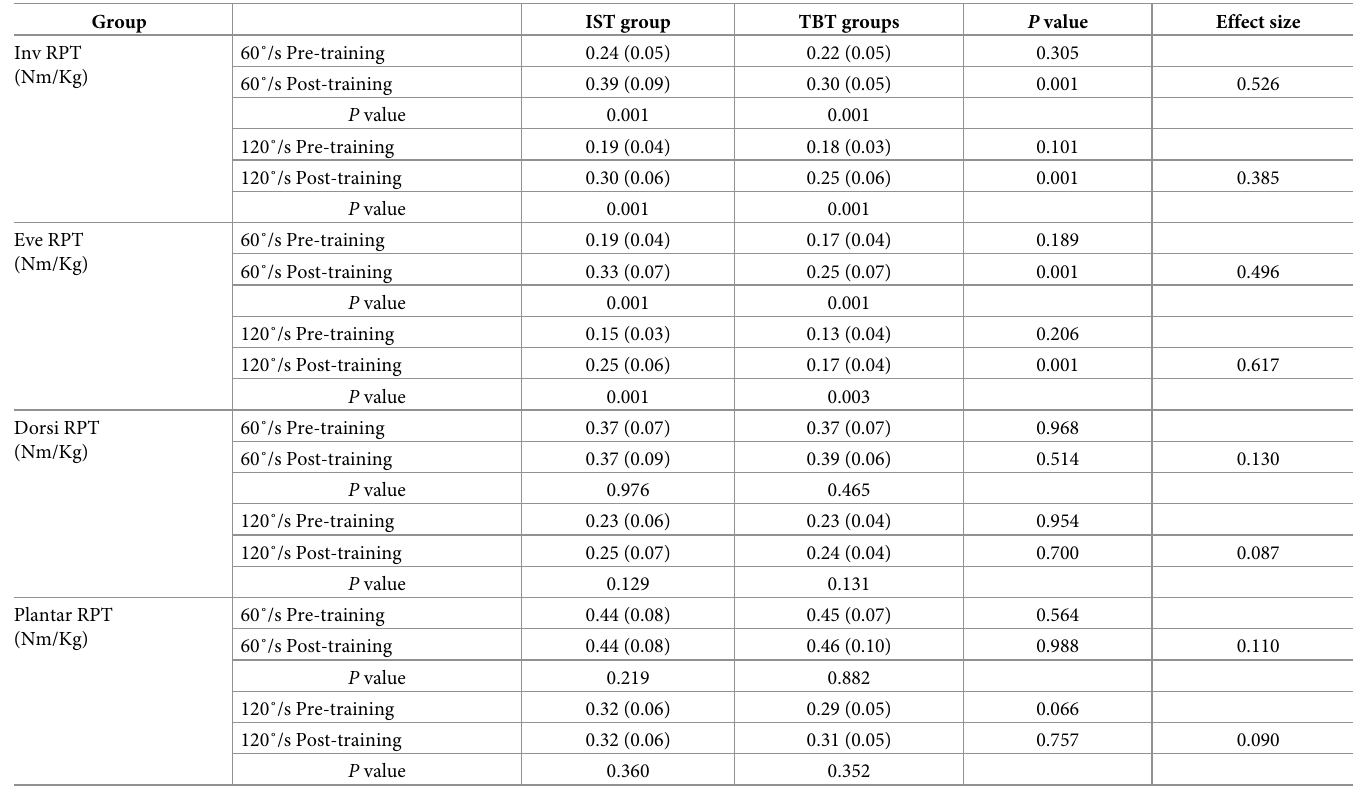
Table 2. Muscle strength of the ankle at 60 and 120 degrees/sec angular velocities in the IST and TBT groups before and after the interventions. Group IST